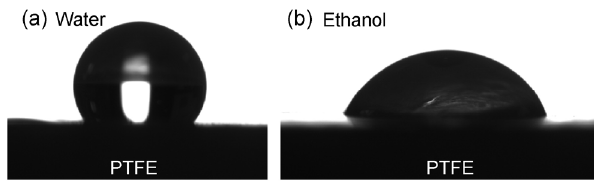
Fig. 2 Contact angle on PTFE: (a) water and (b)